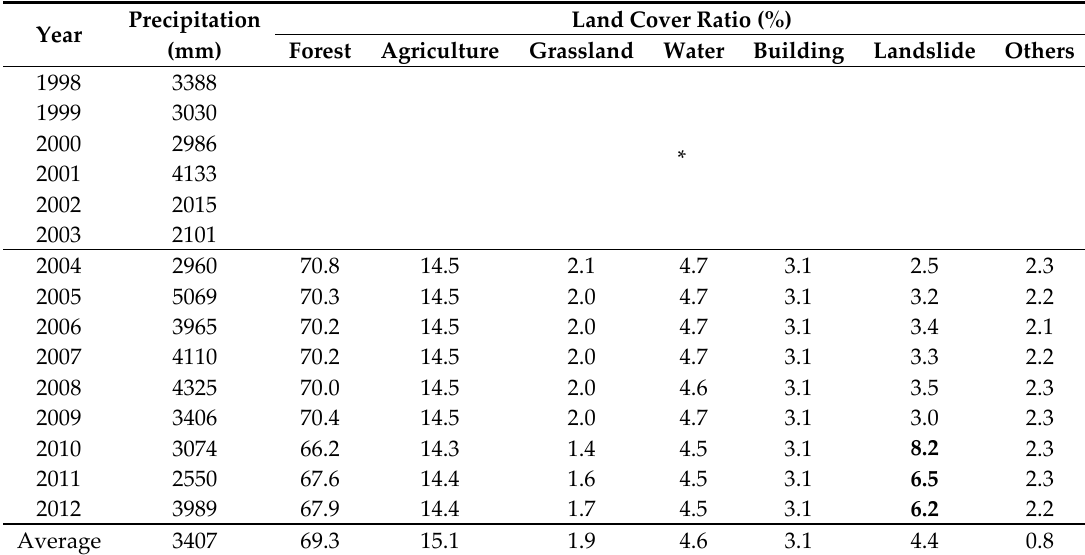
Table 1. Summary of the annual average precipitation derived by Thiessen’s polygon method and land-use/land-cover (LULC) updating results of the Gaoping River Dam (GRD) catchment during the study period.